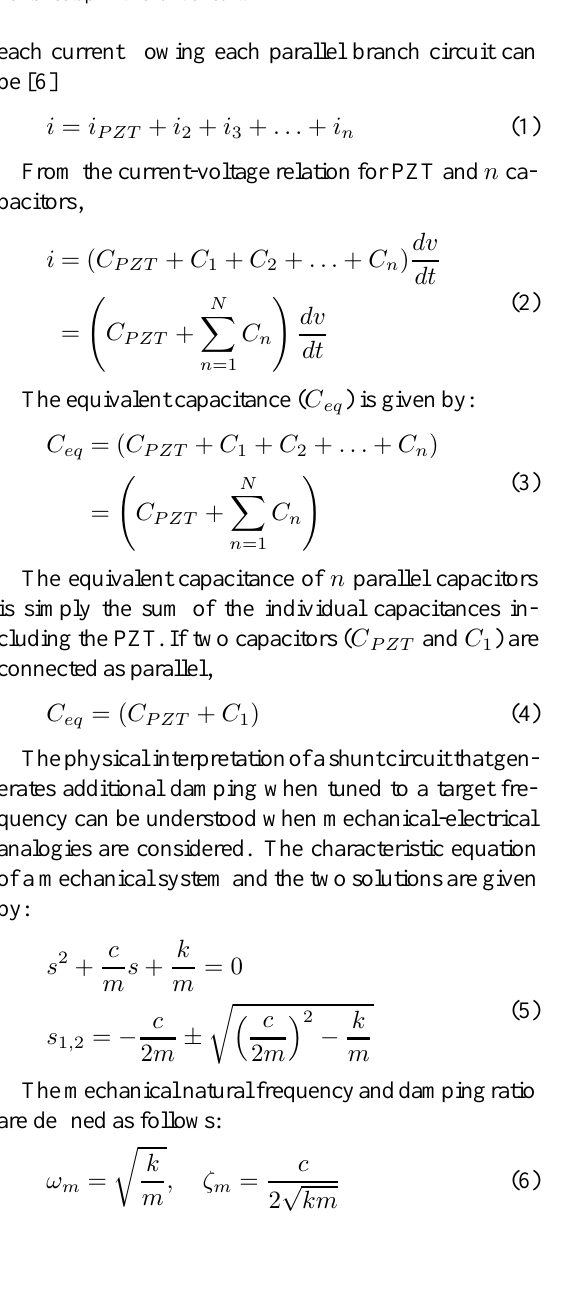
Fig. 1. A schematic drawing of experimental setup with shunt circuit.